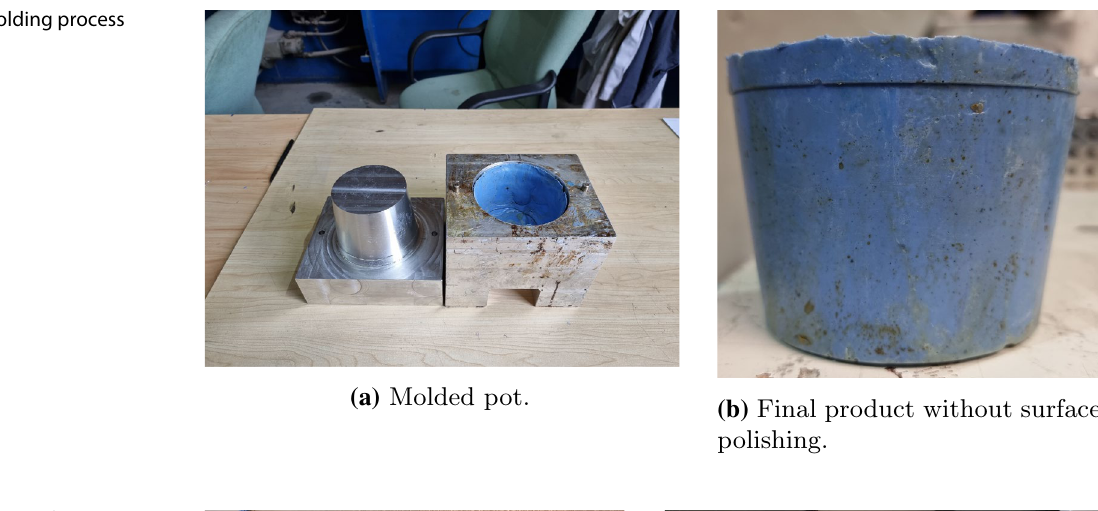
Fig. 21 Comparing the strengths of plastic pots using a hydraulic